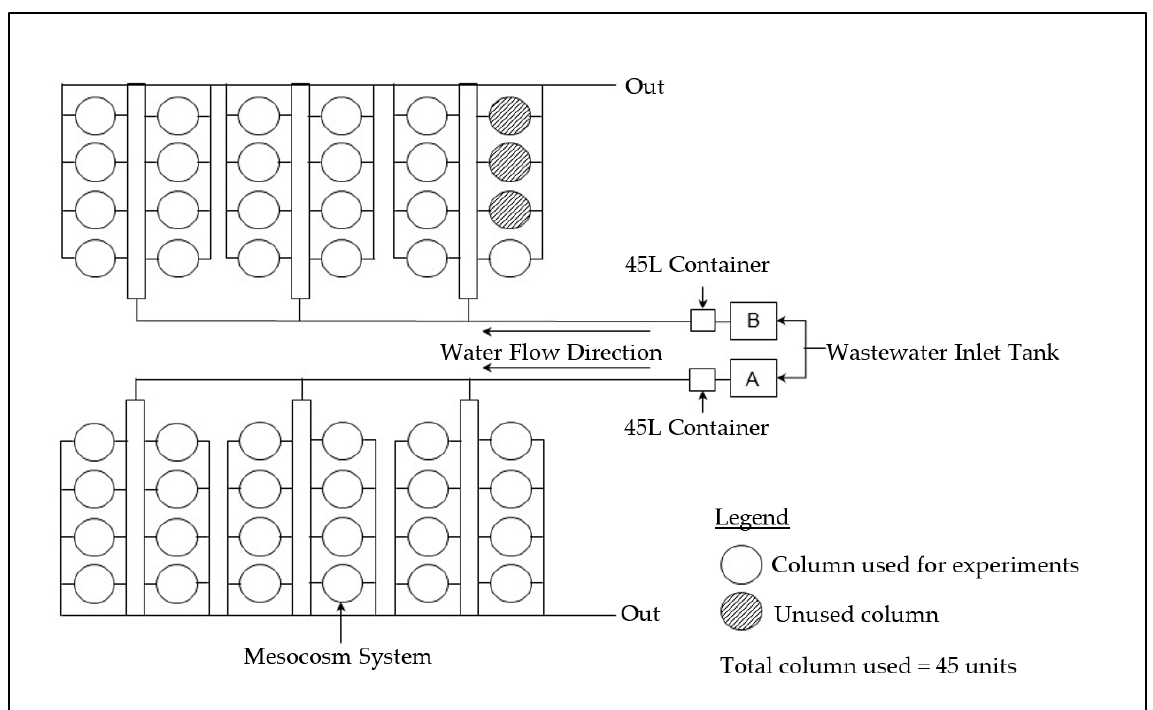
Figure 2. Mesocosm system layout. Because of the limited space for the experimental setup, domes- tic sewage will flow under gravity from separate wastewater inlets of Tank A and Tank B to two different sets of columns. The total columns used in the experiments are 45 units, with three columns used as the control without plants. The diameter for each column is 600 mm.